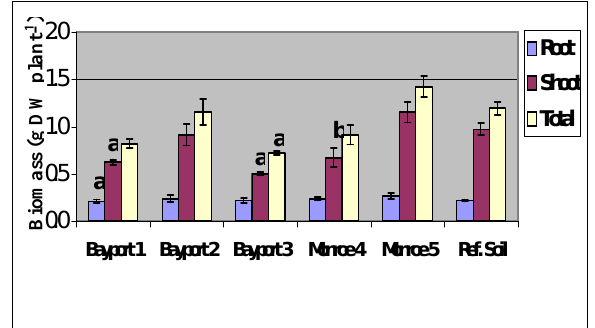
Figure 1: Biomass of Triticum aestivum (mean and standard error; N=4) grown in substrates for 4 weeks. a Statistically significant from the reference soil at the 5 percent significance level; b at the 10 percent significance level according to Dunnet test.